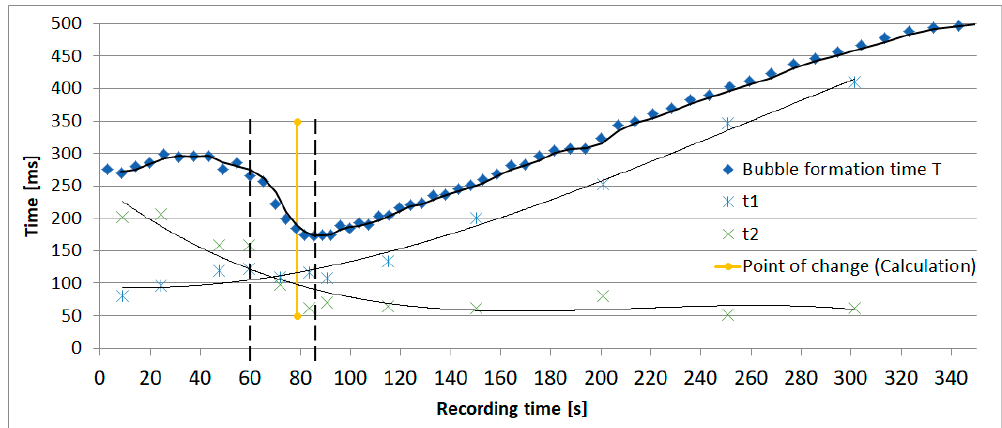
Figure 2. The figure shows exemplarily the bubble formation time T and its phases 𝑡 1 and 𝑡 2 related to the recording time respectively air volume inside the bottle recorded with the setup described in Section